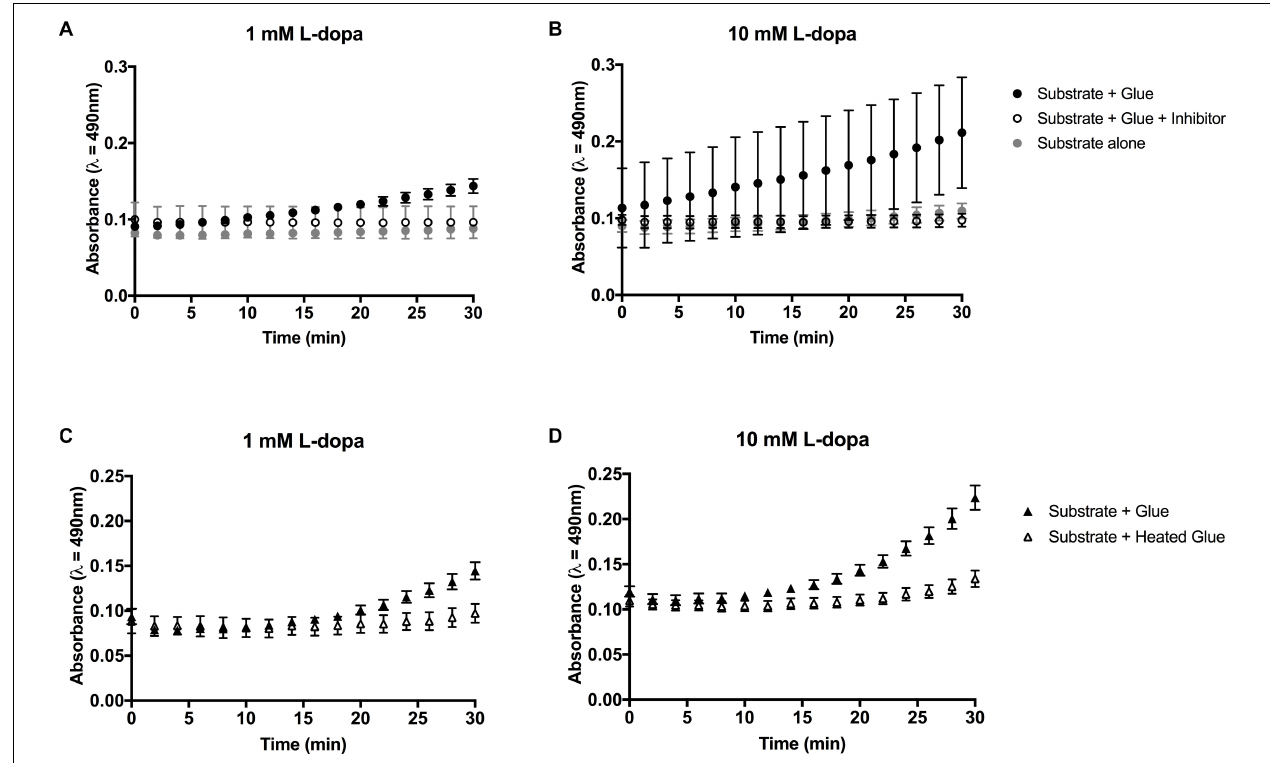
FIGURE 3 | Colorimetric assays for diphenolase activity in barnacle glue with L-dopa as the substrate. (A,B) Diphenolase activity in glue is reduced in the presence of salicylhydroxamic acid (SHAM) inhibitor. (C,D) Heating the glue prior to the assay limits the diphenolase activity. Bars indicate the 95% confidence intervals of the mean at each time point. Non-overlapping data points are considered statistically